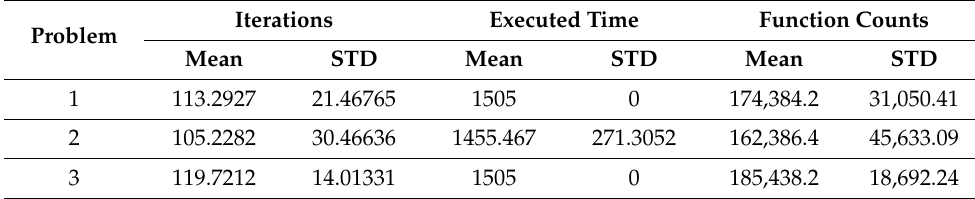
Table 3. Complexity performances for each problem of the